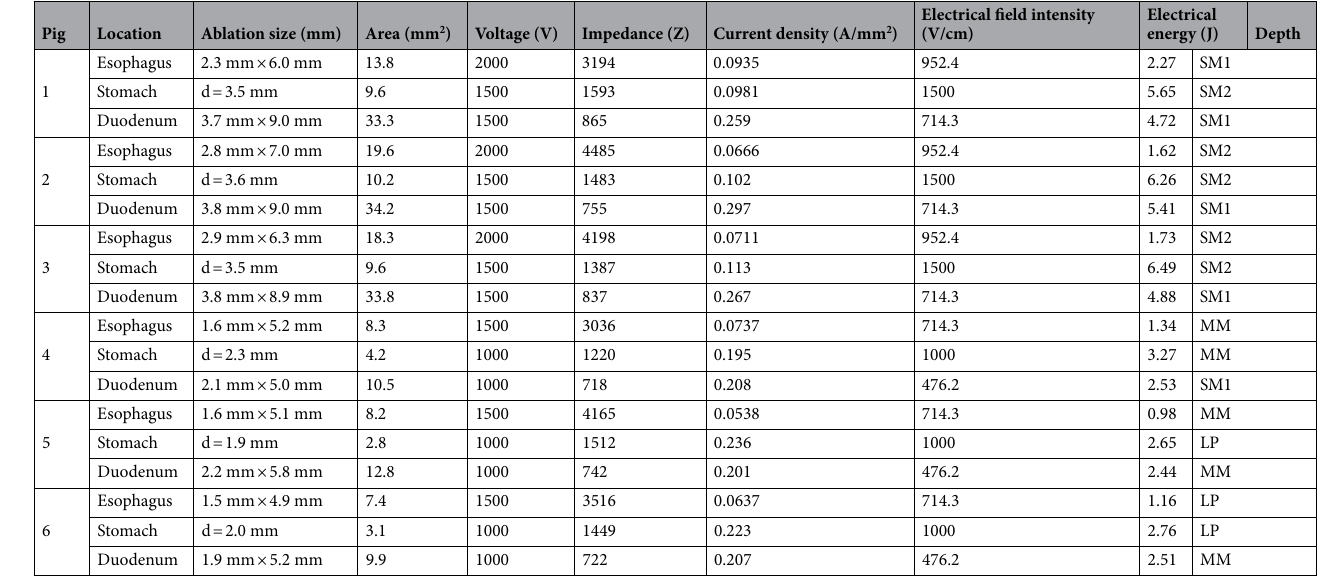
Table 1. Summary of phase 2 experimental outcomes. SM submucosa, LP lamina propria, MM muscularis mucosa, MP muscularis propria, d diameter of needle-type electrode, A ampere, V volt, J Joule.